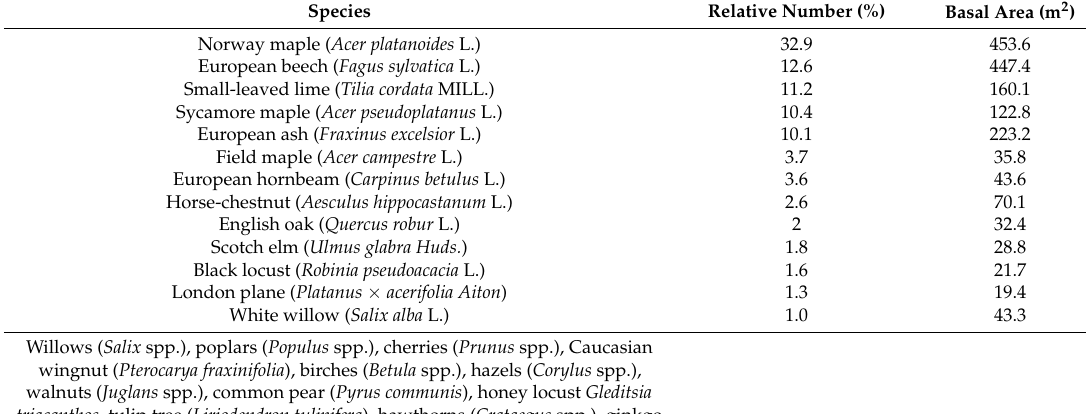
Table 1. Species composition of the south part of Englischer Garten (a total of 9391 trees). Species Relative Number (%) Basal Area (m 2 ) Norway maple ( Acer platanoides